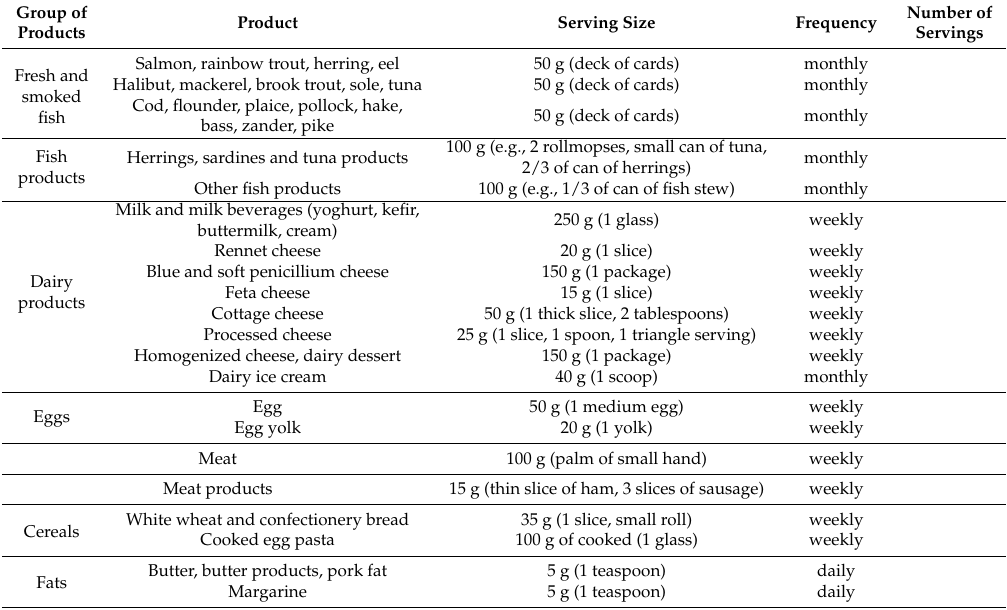
Table 1. The scheme of an applied food frequency questionnaire including food products, serving sizes and frequencies in the VIDEO-FFQ.